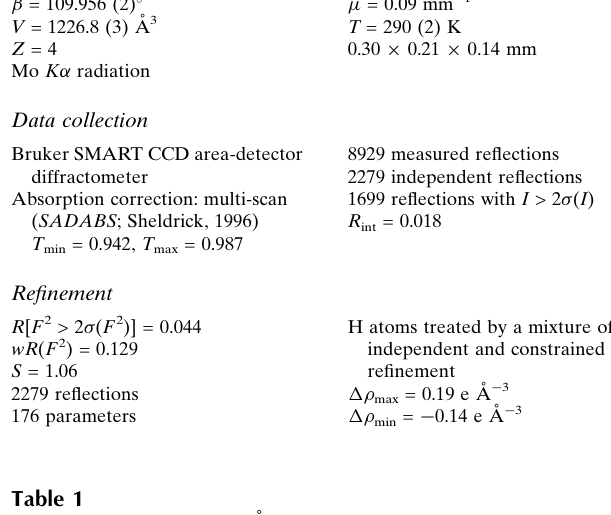
Hydrogen-bond geometry (A˚ , (cid:1)